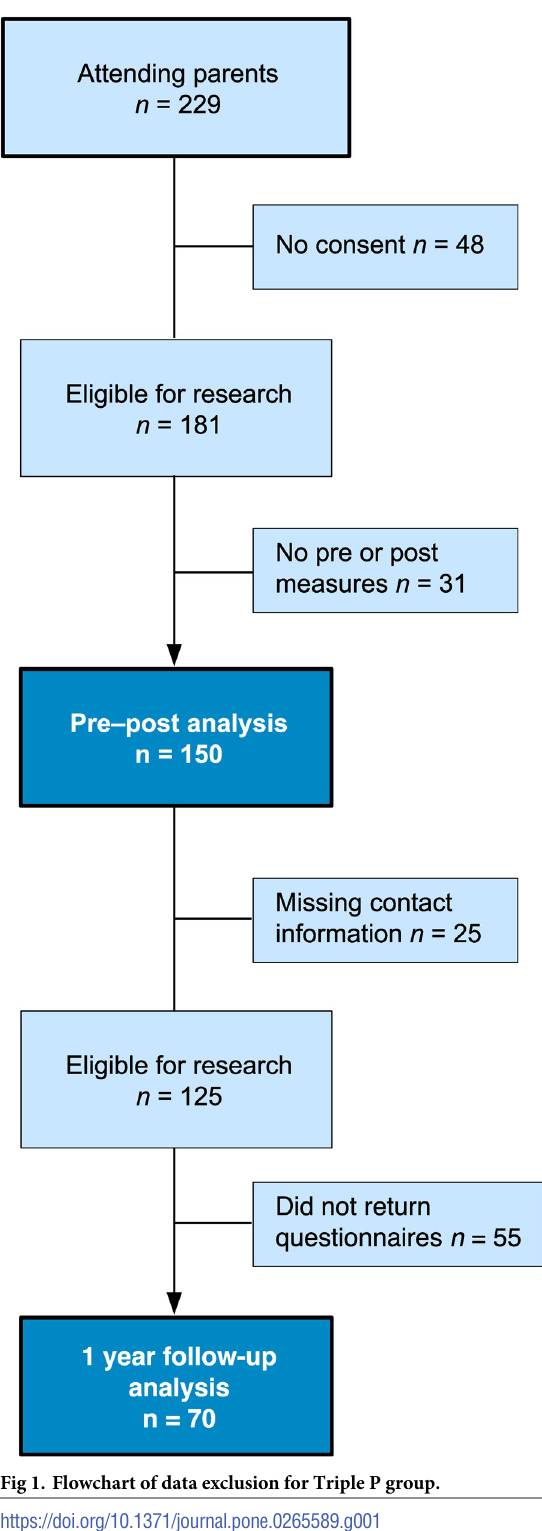
Fig 1. Flowchart of data exclusion for Triple P